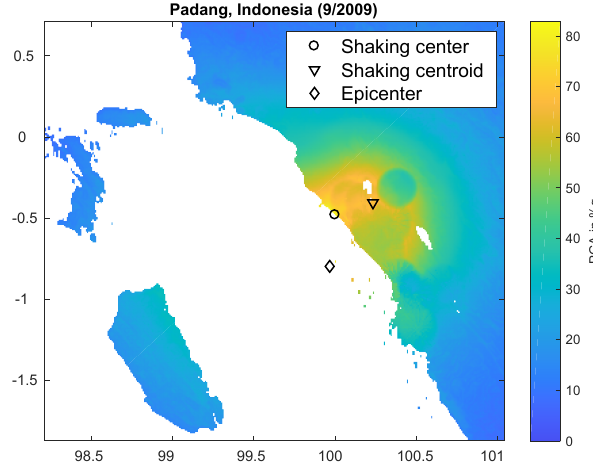
Figure 3. An example of a map of peak ground acceleration based on USGS ShakeMap data. The figure shows the locations of the epicenter, the shaking center and the shaking centroid. The shaking center in this example is 35km away from the epicenter. The dis- tance between the shaking centroid and the epicenter is even 53km.